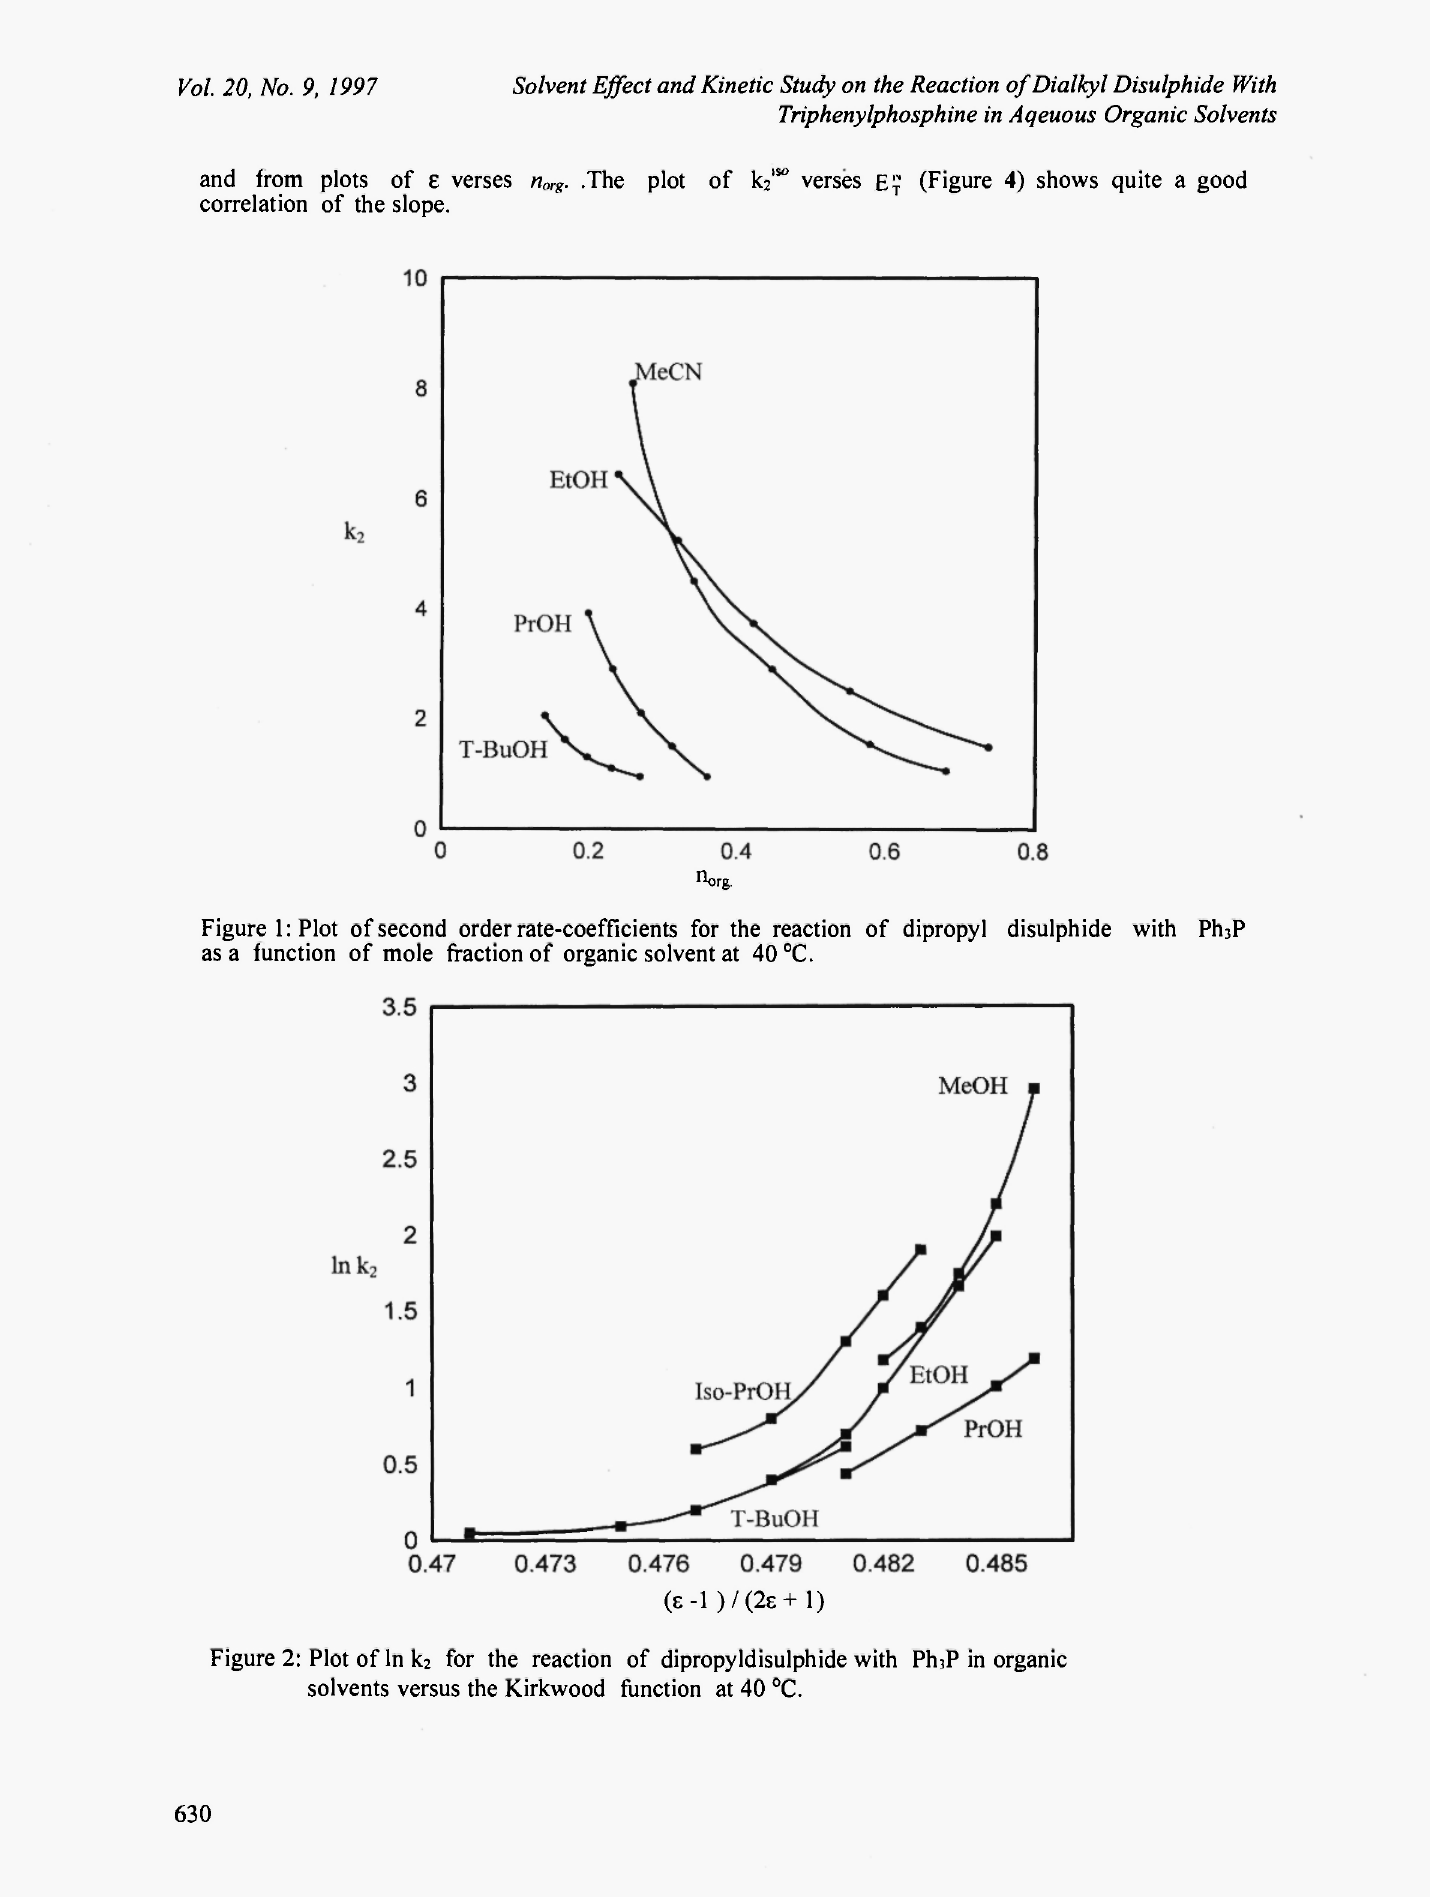
Figure 2: Plot of In k 2 for the reaction of dipropyldisulphide with Ph?P in organic solvents versus the Kirkwood function at 40